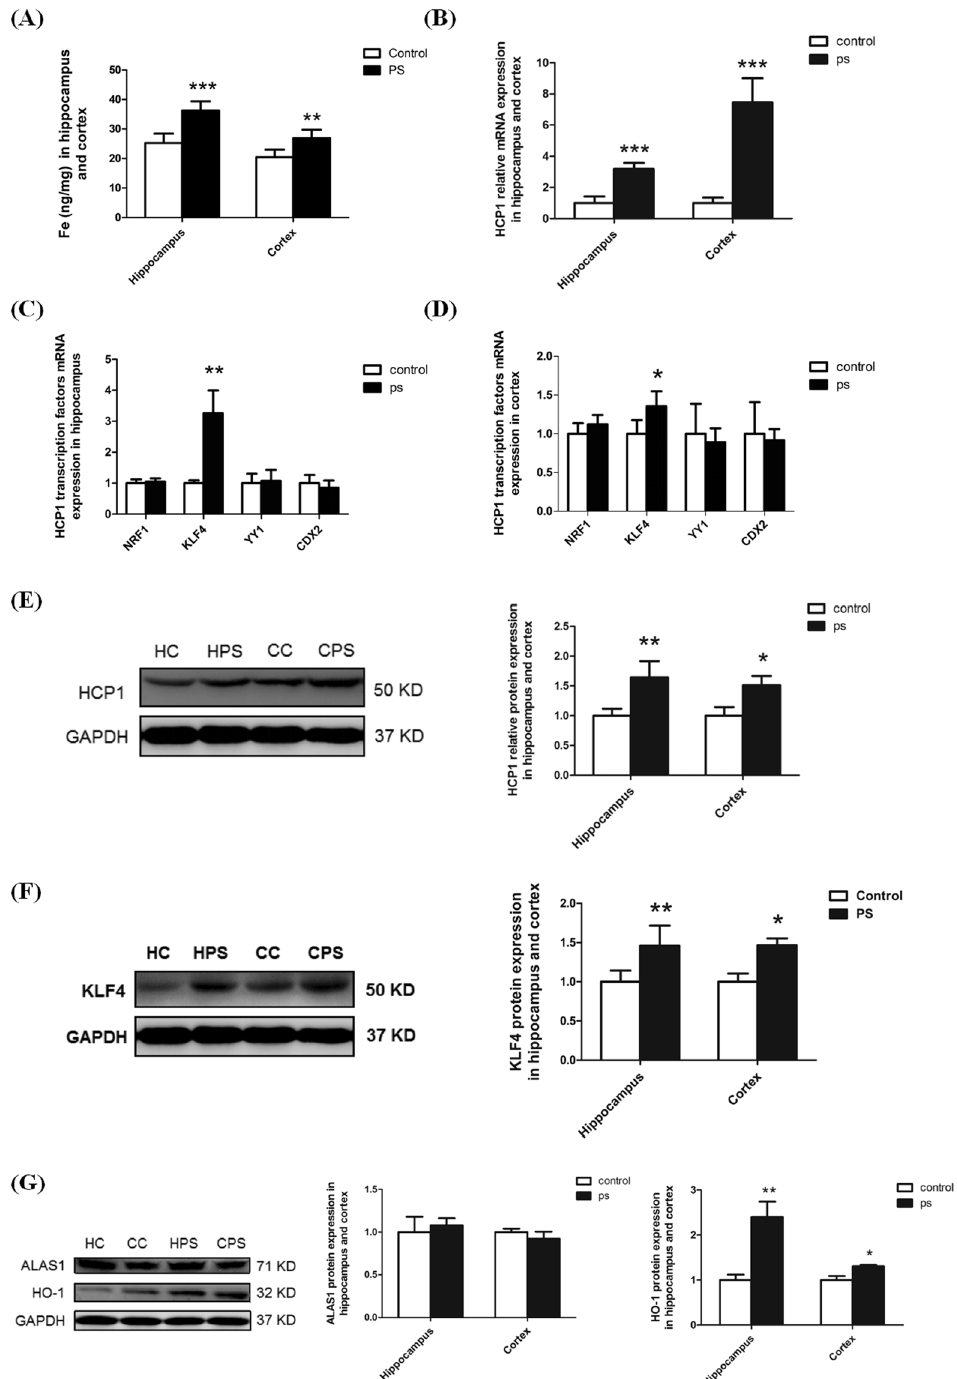
Figure 1. Iron content, HCP1 and its transcription factors expression in hippocampus and cortex of rat brain. ( A ) The iron content in hippocampus and cortex was significantly elevated in PS group compared with the control group. ( B ) RT-PCR analysis showed that HCP1 mRNA expression in hippocampus and cortex of PS rat brain was significantly higher than in control group. ( C , D ) The transcription factors NRF1, KLF4, YY1 and CDX2 mRNA expression in hippocampus and cortex of the rat brain: only KLF4 mRNA expression was significantly increased in PS group, and others have no significant differences compared with the control group. ( E ) Western blot analysis revealed that HCP1 protein expression was increased in hippocampus and cortex of the PS rat brain. ( F ) Western blot analysis also demonstrated that KLF4 protein expression was increased in hippocampus and cortex of the PS rat brain. ( G ) Western blot showed that ALAS1 expression in hippocampus and cortex of PS rat brain has no differences with the control group, while the expression of HO-1 was significantly increased in PS group. Values are means ± SD. * p < 0.05; ** p < 0.01; *** p < 0.001. (HC: hippocampus in control group; HPS: hippocampus in PS group; CC: cortex in control group; CPS: cortex in PS